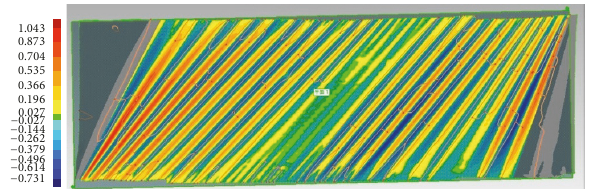
Figure 7: Three-dimensional surface wrinkling pattern.